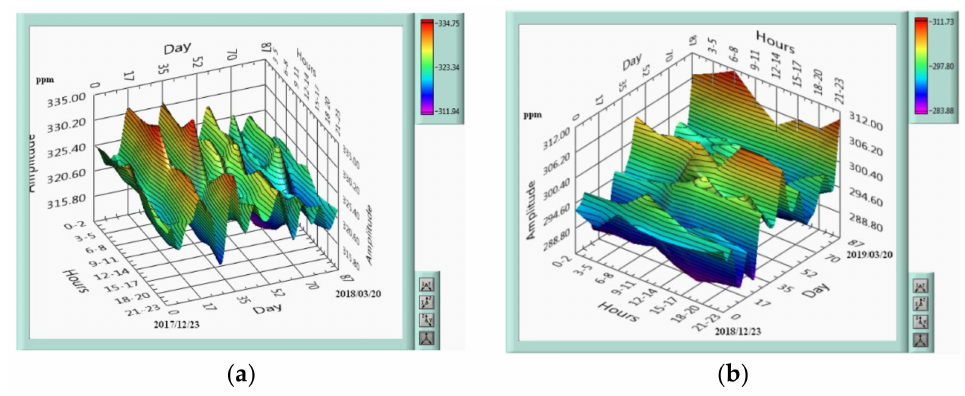
Figure 11. CO 2 in Nehoiu winter: ( a ) 2017; ( b )